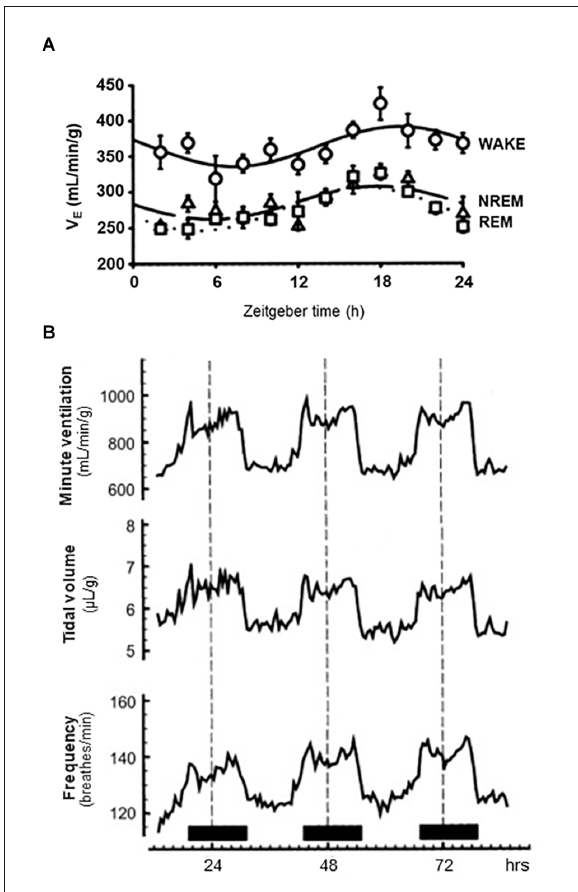
FIGURE2 Circadian and sleep state-dependent effects on ventilation. (A) 72-h traces of average minute ventilation (top), tidal volume (middle) and breathing frequency (bottom) in adult male rats housed under a 12:12 h light:dark cycle and receiving room air (21% O 2 , balance N 2 ). Solid horizontal bars at the bottom indicate periods where lights were off. (B) 24-h trace of average minute ventilation in rats during wake, non-rapid eye movement (NREM) sleep, and rapid-eye movement (REM) sleep as indicated. All animals housed in a 12:12 h light:dark cycle. (A) Redrawn with permission from Seifert and Mortola (2002). (B) Redrawn with permission from Stephenson et al.